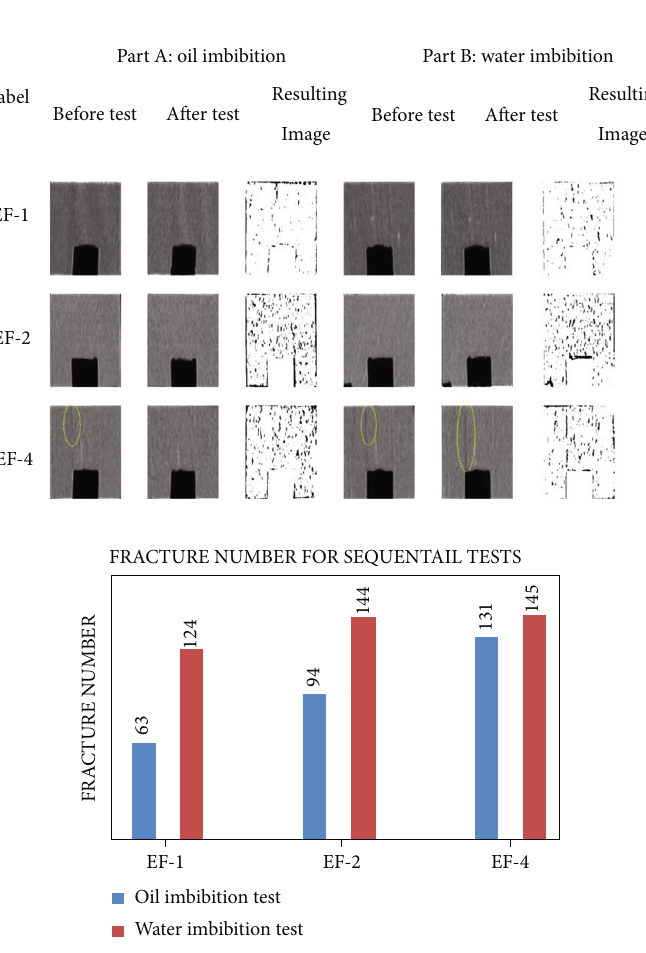
Figure 12: Results from Liu and Sheng [10].